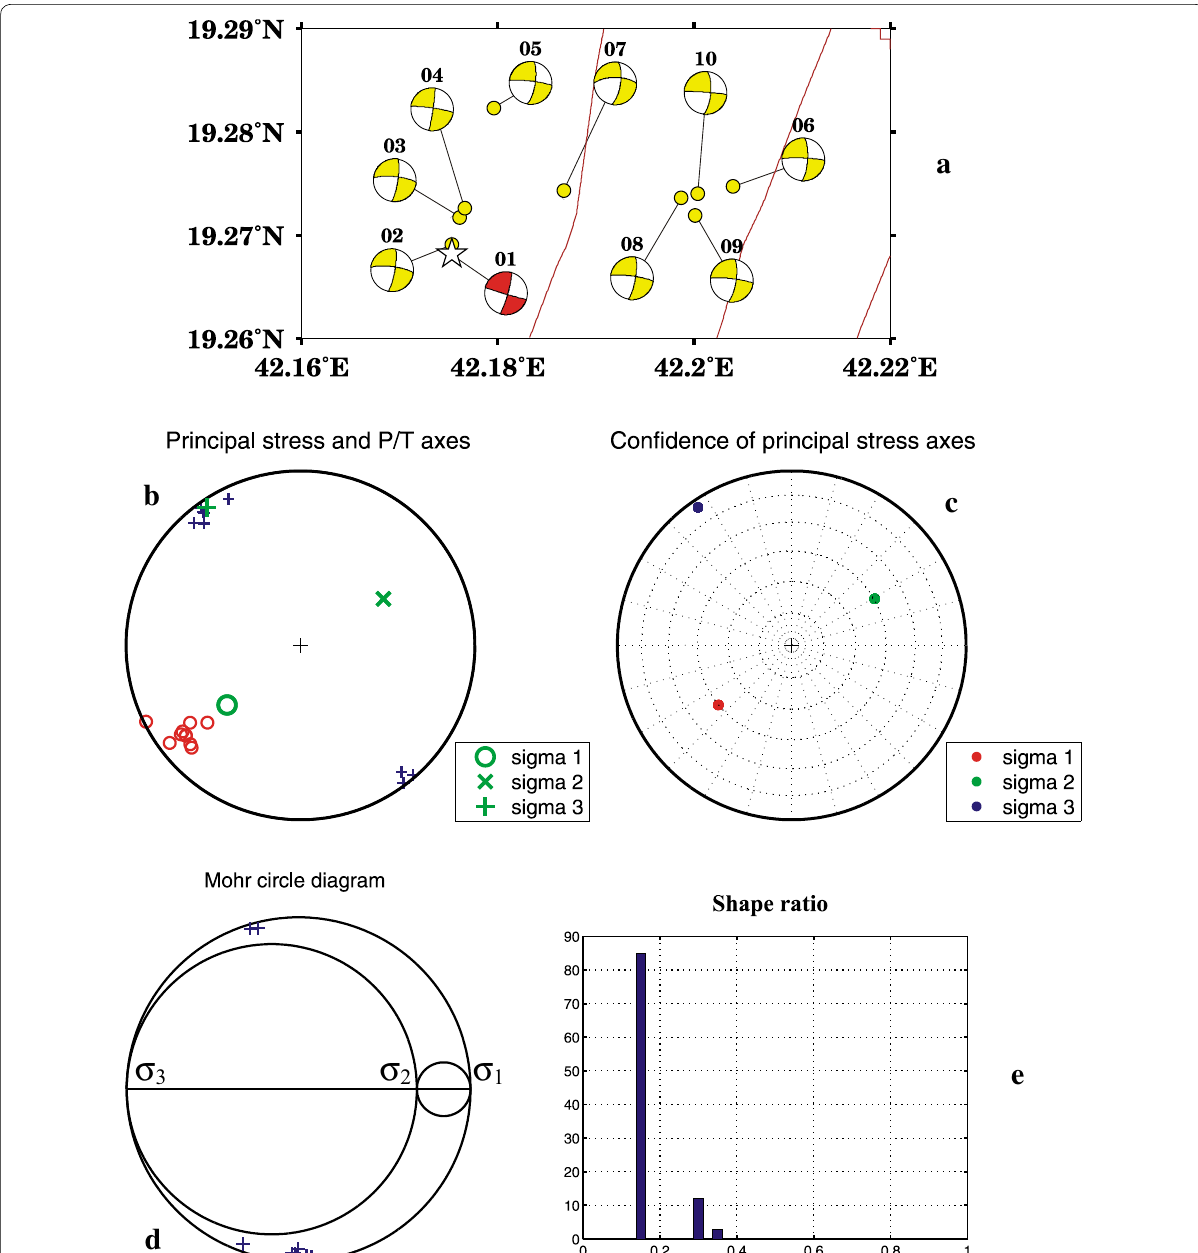
Fig. 7 Iterative inversion of stress and fault orientations. The plot shows: a the distribution of focal mechanisms of the mainshock (red beach ball) and aftershocks (yellow beach ball) of the fault parameters listed in Table 1, b P‑axes (red circles) and T‑axes (blue plus signs) and the corresponding principal stress directions ( σ 1 , σ 2 , and σ 3 ), c confidence of principal stress axes retrieved from random perturbation of the focal mechanism dataset. d Mohr’s circle diagram with the positions of fault planes, and e the stress ratio histogram for the 2017 earthquake